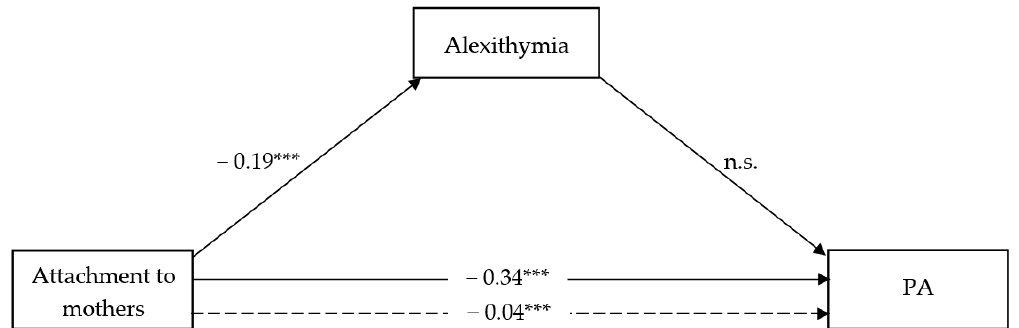
Figure 2. Attachment to mothers and PA. *** p < 0.000; ns = not significant; dotted line = Total effect.